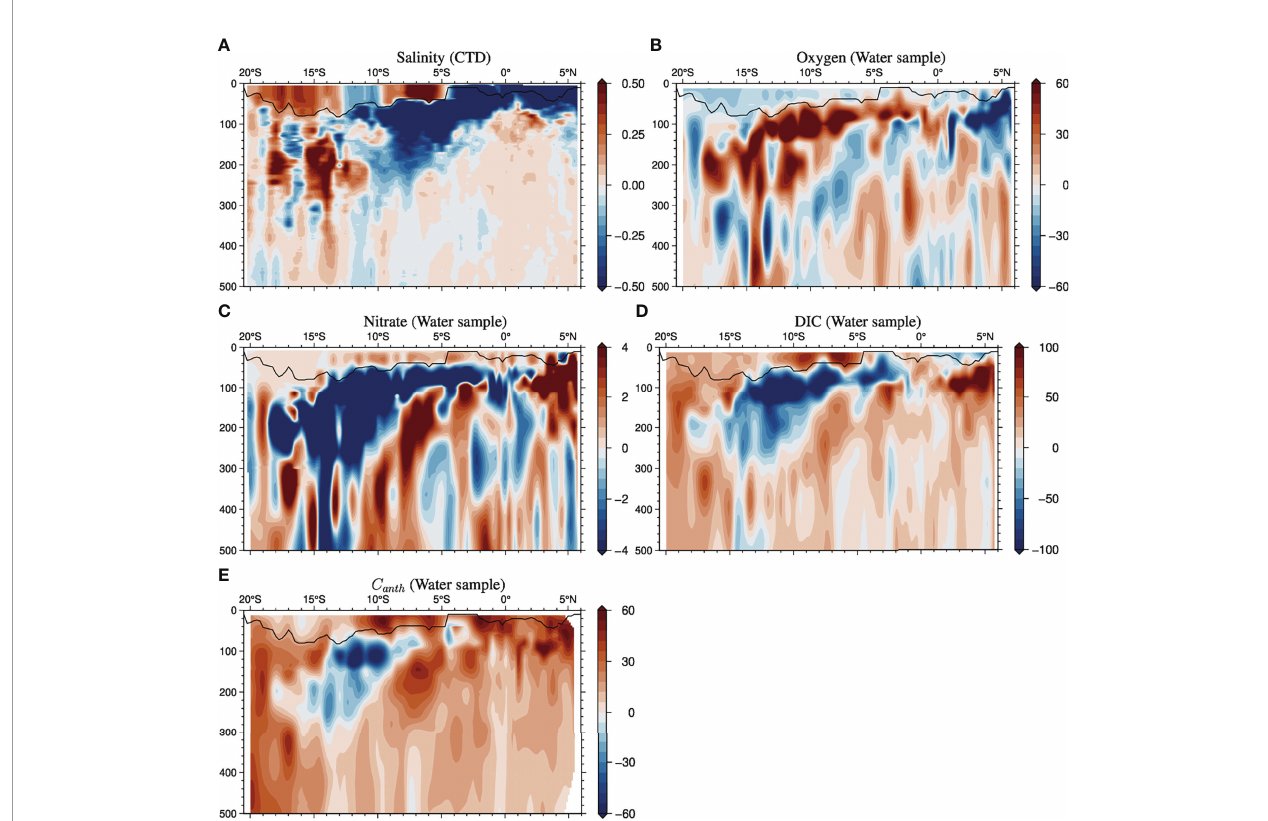
FIGURE 2 | Changes (from September 1995 to December 2019) in salinity (A) , DO (B) , nitrate (C) , DIC (D) and anthropogenic carbon (E) on isobar surfaces along the 80°E section ( Figure 1 ). Mixed layer depths, where the densities were denser than 0.125 kg m -3 at 10 dbar, are shown with black